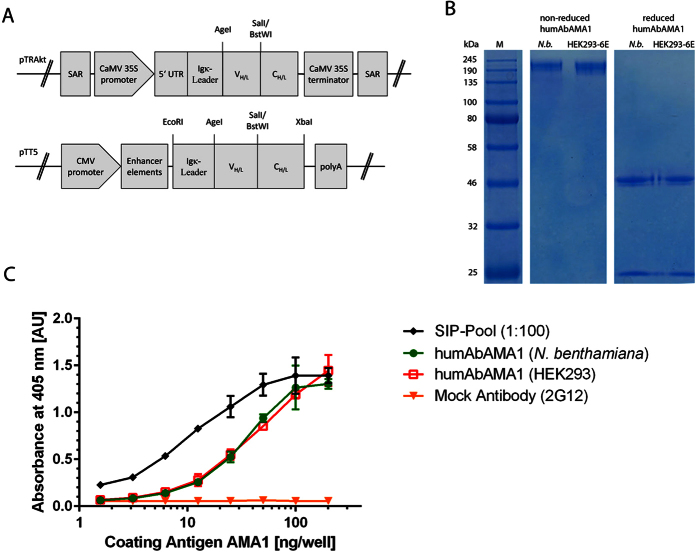
Cloning, expression and binding specificity of humAbAMA1.HumAbAMA1 was cloned as full length expression construct in both vectors pTRAkt and pTT5 for transient expression in plants and in HEK293-6E cells, respectively (A). The expression and purity of the full length antibodies expressed both in plants (N. benthamiana) and in mammalian cells (HEK293) was controlled by SDS-PAGE. Both non-reduced and reduced samples of the antibodies were loaded on the gel (B). The binding of humAbAMA1to AMA1 (3D7) was tested by indirect ELISA. Dilutions of the antigen (AMA1 (3D7)) were coated onto ELISA plates, then human antibodies were applied followed by goat anti-human antibody coupled to alkaline phosphatase (Dianova, Hamburg, Germany). Black diamonds: Semi-immune (premune) plasma pool; green circles: humAbAMA1 (N. benthamiana); Red open squares: humAbAMA1 (HEK293); orange inverted triangles: mock control antibody (2G12).